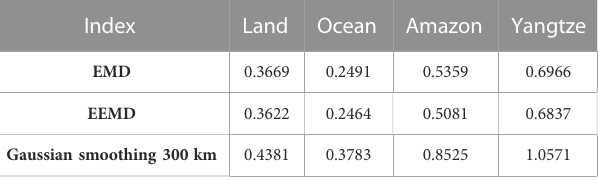
TABLE 2 The RMSEs (unit: cm) of EEMD, EMD and 300 km Gaussian smoothing together with DDK7 in terms of mean mass change.